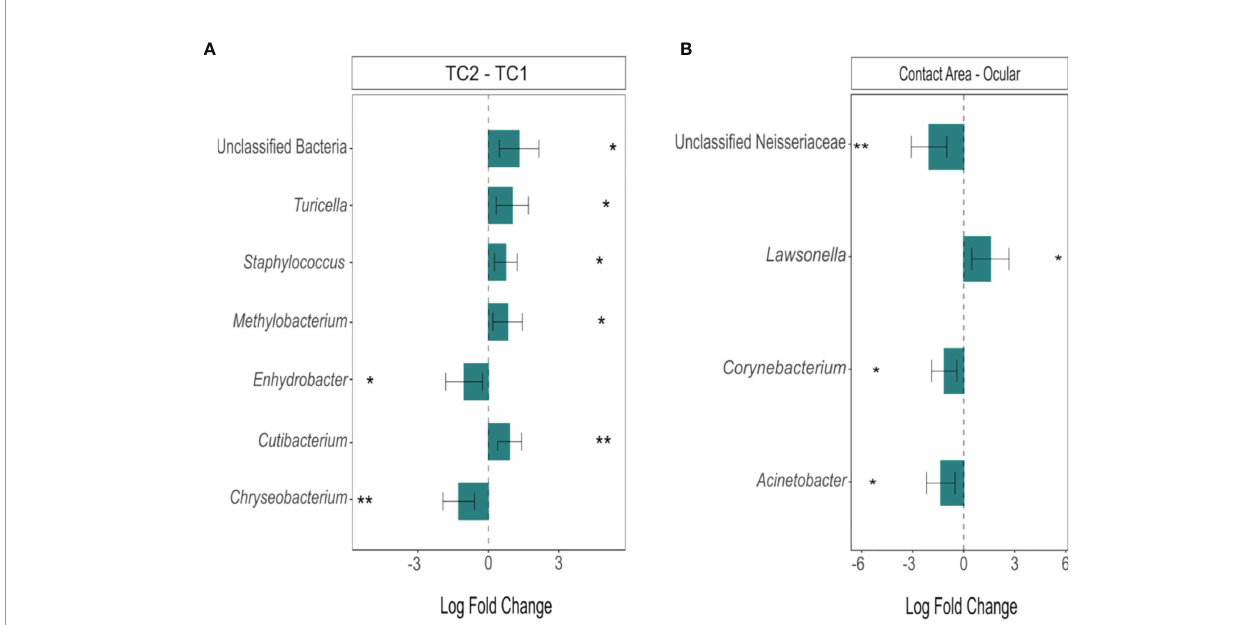
FIGURE 5 | Differentially abundant genera between (A) the two locations (TC2 – TC1) and (B) the sample types at TC1 (contact area – ocular), calculated using ANCOM-BC. Bars represent the estimated log-fold change (natural log) of genera between the selected conditions, error bars represent the 95% con fi dence intervals. Asterisks mark a statistically signi fi cant difference between the conditions (*p adj < 0.05; **p adj < 0.01), based on two-sided Chi-square tests using W with Benjamini-Hochberg correction; TC, Tertiary